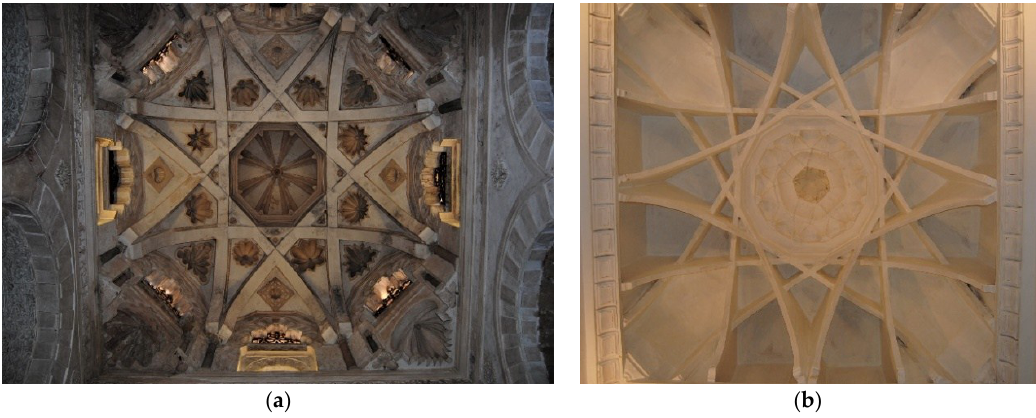
Figure 11. Intersecting ribbed vault that precedes the door of the s.abat. in The Great Mosque of Cordova ( a ). Photo took by author. Intersecting ribbed belonging to the Toro-Buiza house, Reales Alc á zares de Sevilla ( b ). Photo took by